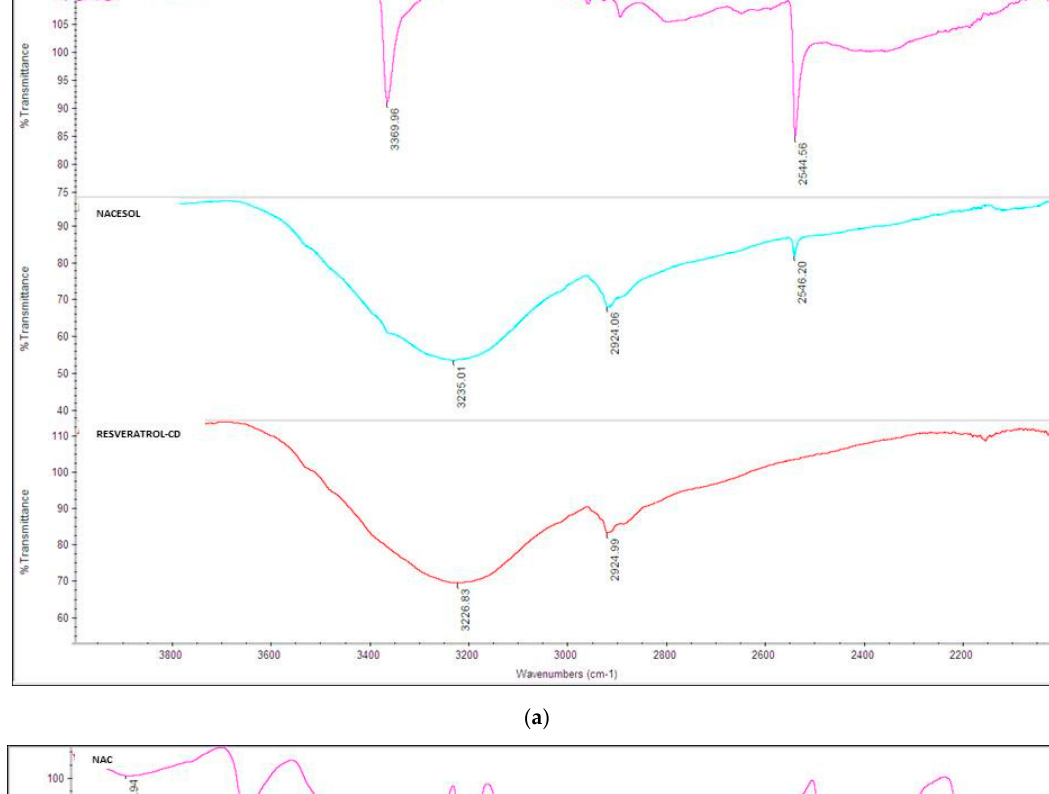
Figure 3. Pattern X-ray powder diffraction (XRPD) of ( a) Nacesol TM ; ( b ) Cyclodextrin; ( c ) physical mixture (MF) NAC: Resveratrol: cyclodextrin (10:15:75 w:w:w); ( d) Resveratrol; ( e) NAC.